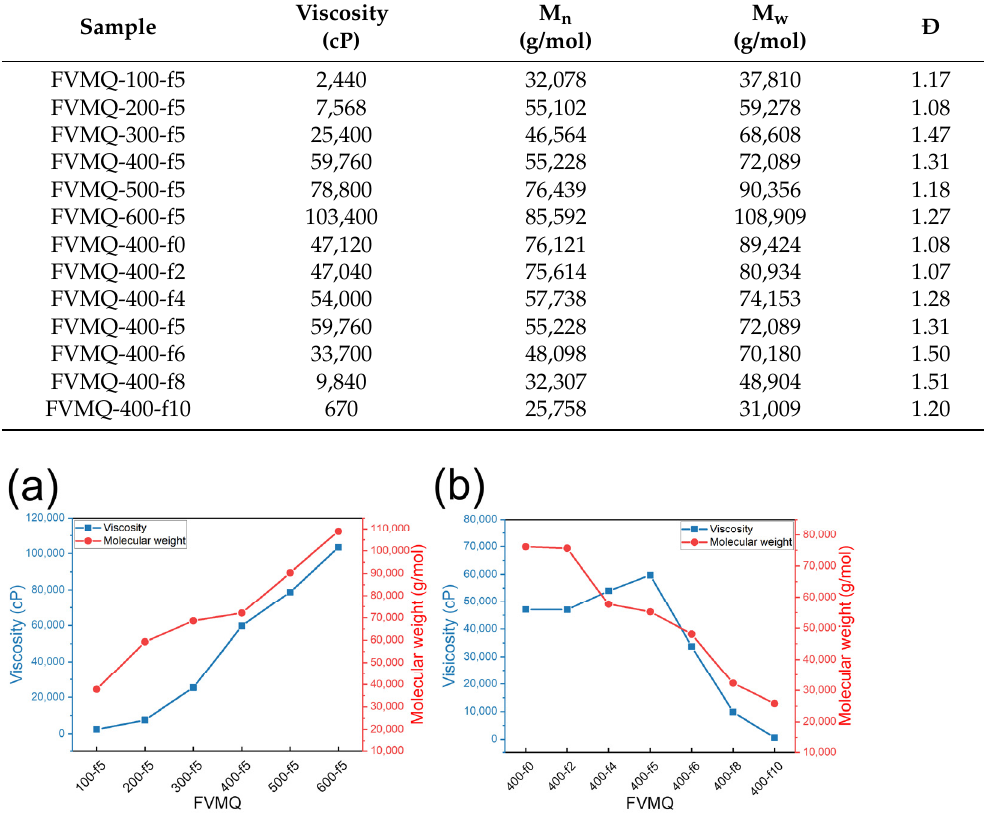
Figure 4. Correlation between the viscosity and molecular weight of FVMQs with ( a ) different chain-lengths and ( b ) different fluorine